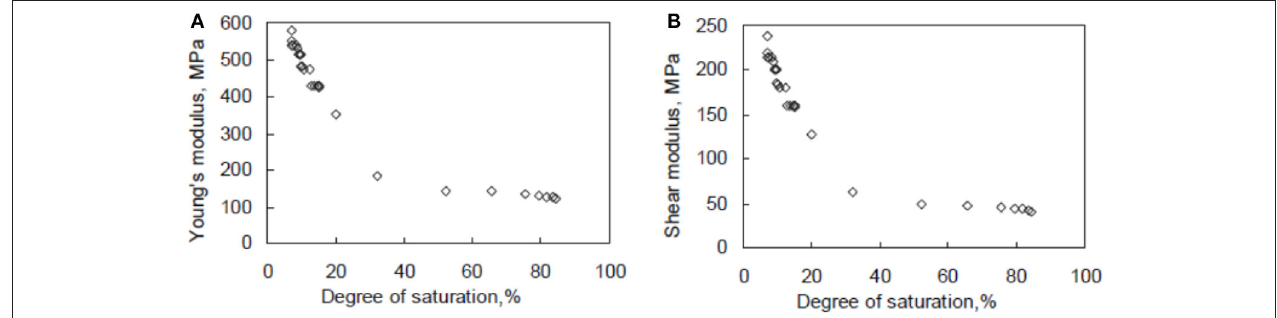
FIGURE 3 | Impact of degree of saturation for silty sand soil on (adopted from Byun et al., 2013): (A) Young’s modulus; (B) shear